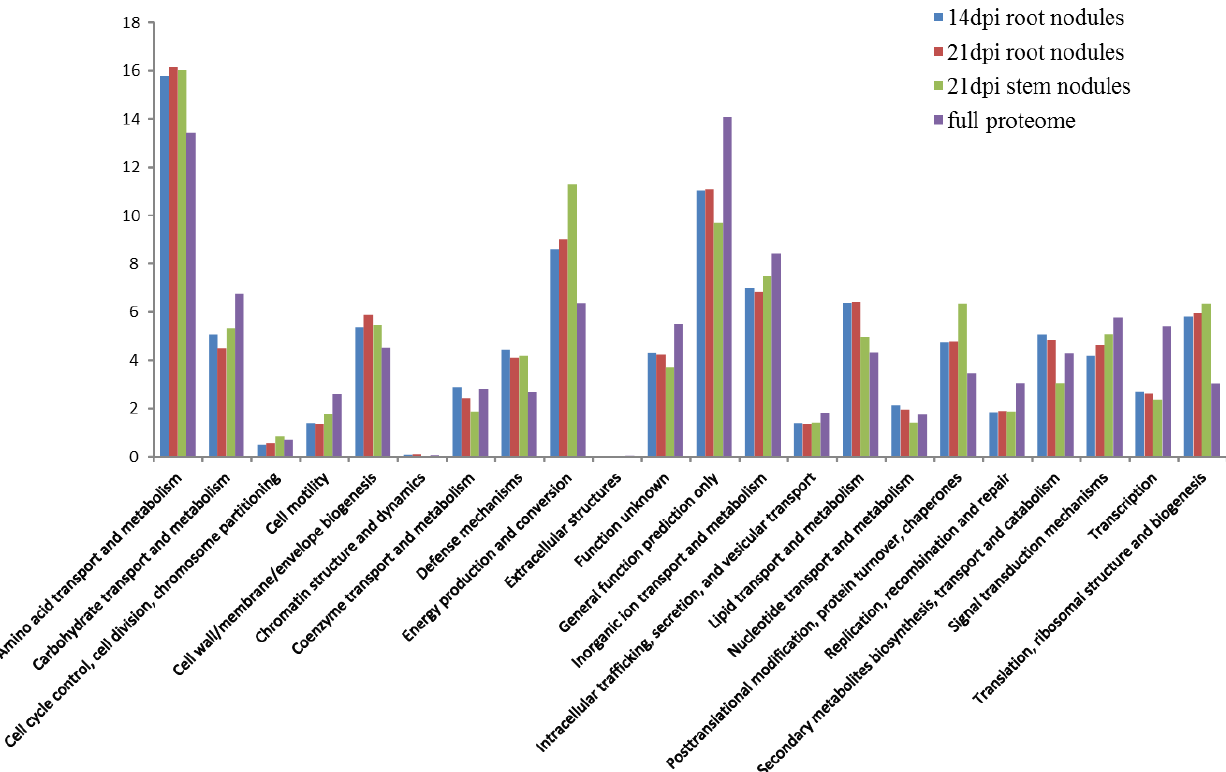
Figure 2. Functional distributions of predicted and bacteroid proteomes according to Clusters of Orthologous Groups (COG) classification, y axis represents percentage of the indicated